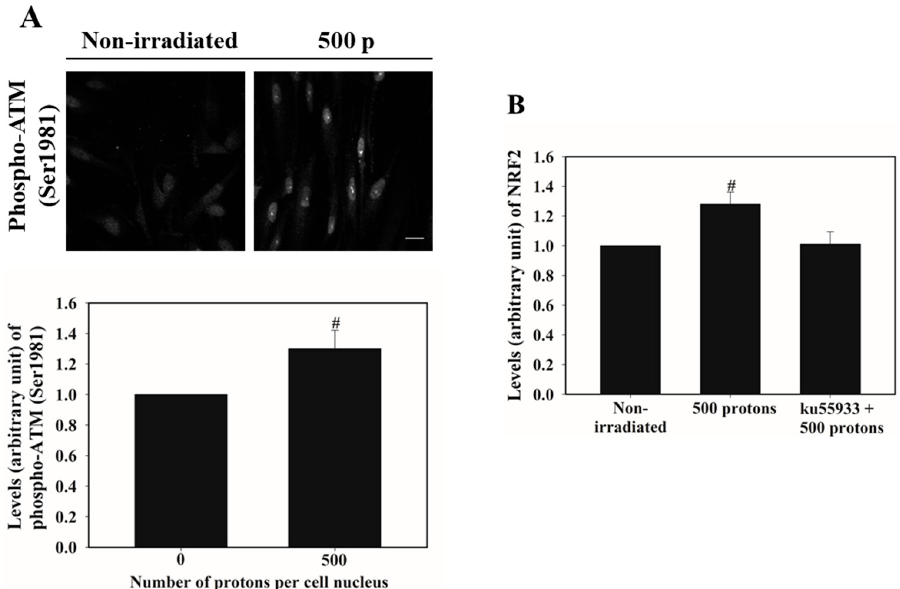
Figure 4. The nucleus of the WI-38 cells was targeted by 500 protons. One hour later, the levels of phosphorylated ATM (Ser1981) were detected by immunofluorescence staining. Scale bar = 30 µm ( A ). After being exposed to 10 µmol/L ku55933 for one hour, WI-38 cells were exposed to 500 proton nucleus irradiation. Then, the cells were incubated for 12 h in the medium containing 10 µmol/L ku55933( B ). The nucleus accumulation of NRF2 was detected by immunofluorescence staining. # P value < 0.05.